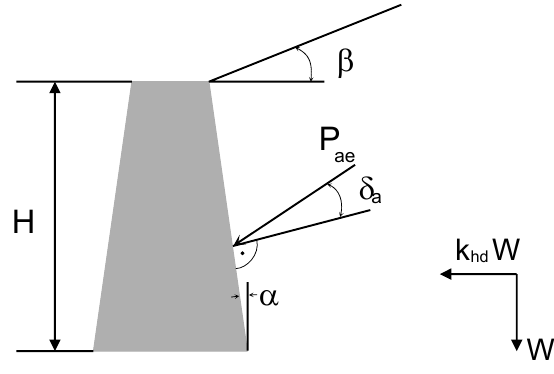
Figure 4. Scheme of solved example